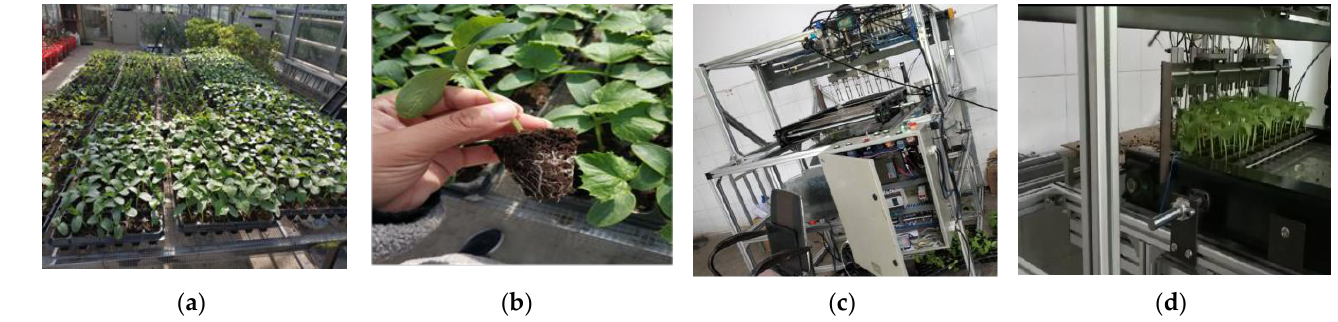
Figure 10. Test equipment and conditions: ( a ) 72-hole plug seedlings; ( b ) growth of cucumber seedlings; ( c ) pick-up mechanism; ( d ) bench test of picking seedlings.